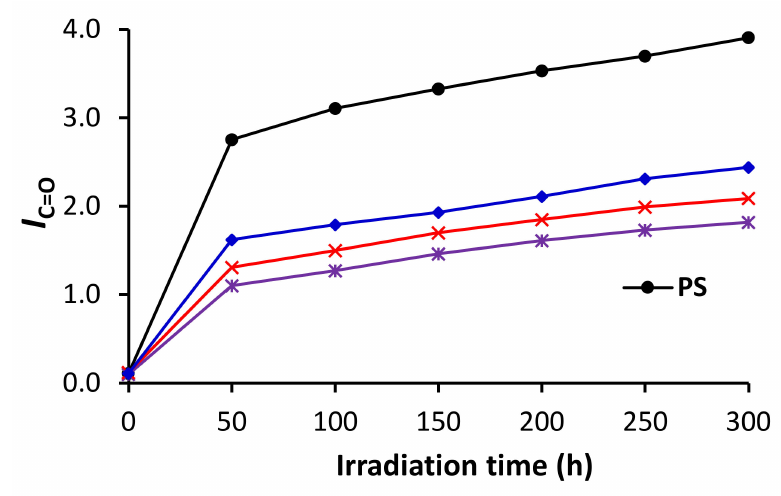
Figure 3. A plot of I C=O of PS films as a function of UV irradiation time.